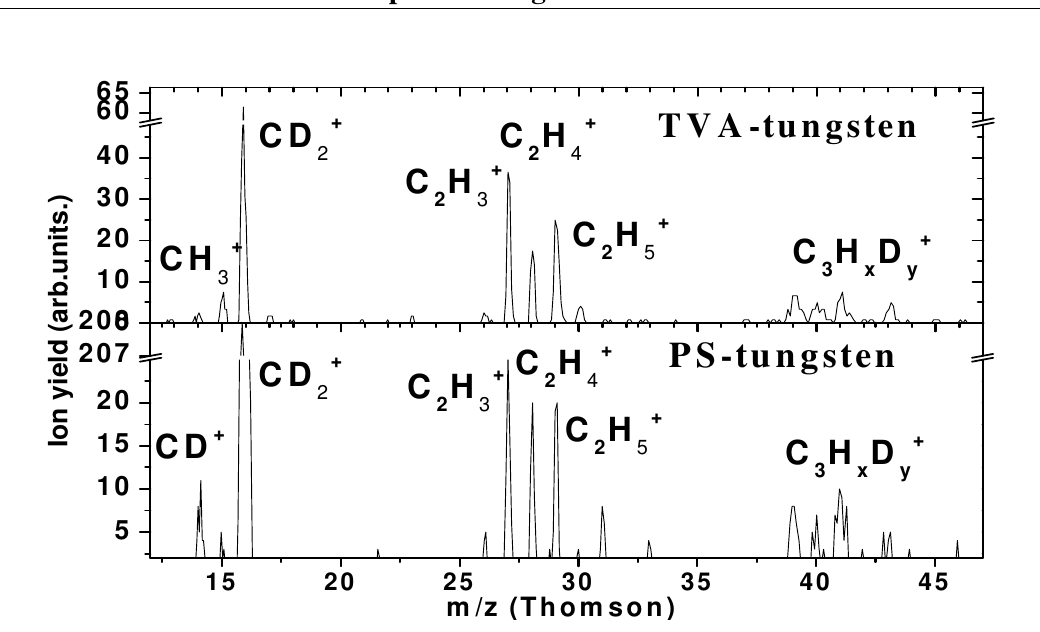
FIG. 3: PRODUCT ION MASS SPECTRA OF CD 2+ INTERACTING WITH INCIDENT ENERGY OF 30 EV, WITH HYDROCARBON COVERED PS TUNGSTEN AND TVA TUNGSTEN